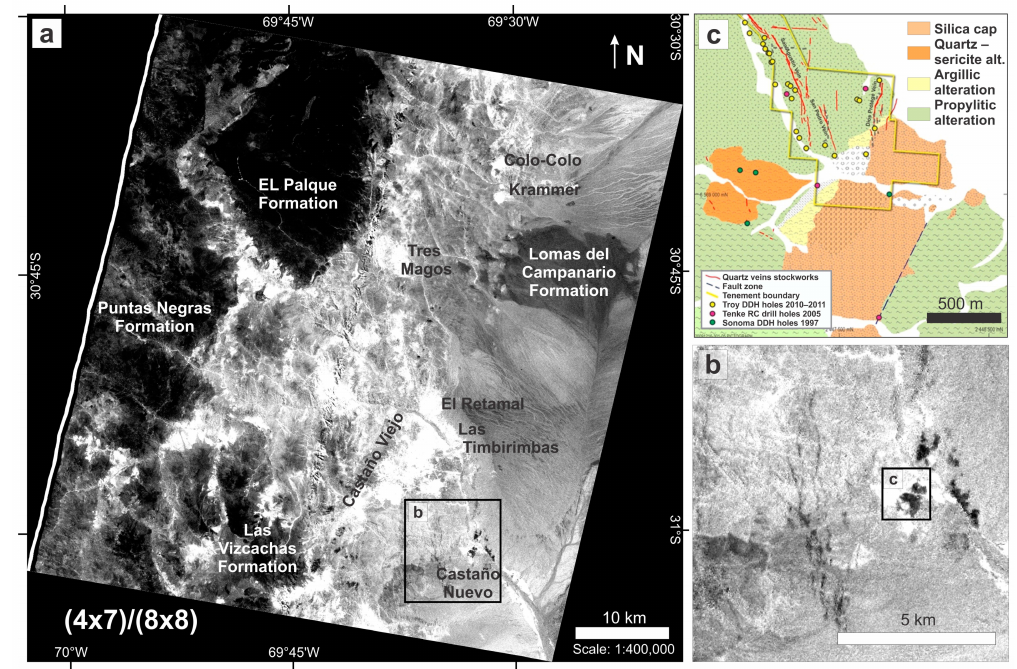
Figure 7. ( a ) The ASTER bands (4 × 7)/(8 × 8) operation was developed for this study to highlight areas with both phyllic and argillic alteration (bright pixels). This band math operation clearly identifies the location of the Puntas Negras, El Palque, Lomas del Campanario and Las Vizcachas formations (dark shades). ( b ) Enlarged image of the Castaño Nuevo district, which shows hydrothermal alterations rich in OH-bearing and clay mineral (light shades to white) and the more localized silicified zones and the N-trending rhyolite dykes (black to dark grey). The hydrothermal alteration zones mapped by the ASTER bands (4 × 7)/(8 × 8) operation are consistent with the alteration map proposed by Troy Resources Ltd. for the Castaño Nuevo area ( c